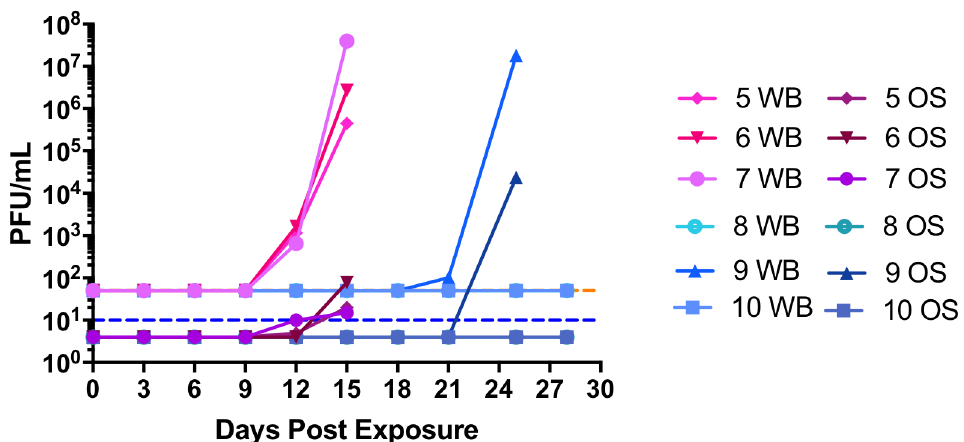
Fig 8. Prophylactic treatment with c8A and c7D11 prevents or delays virermia and viral shedding. EDTA whole blood (WB) and media from oral swabs (OS) were inoculated on to BSC-1 cells, stained, and plaques enumerated five days later. Treated animals (shades of blue); Mock or off-target treated (shades of pink). Limits of detection for whole blood (dashed orange line) and for oral swabs (dashed blue